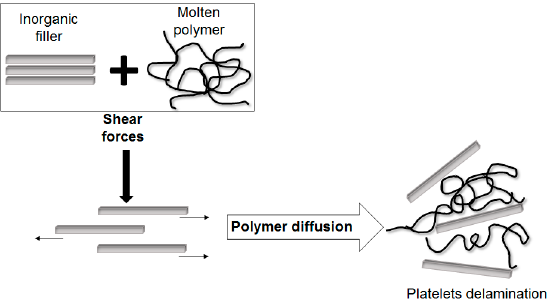
Figure 19. Schematic representation of the melt processing (Redraw and adapted figure from [93]).